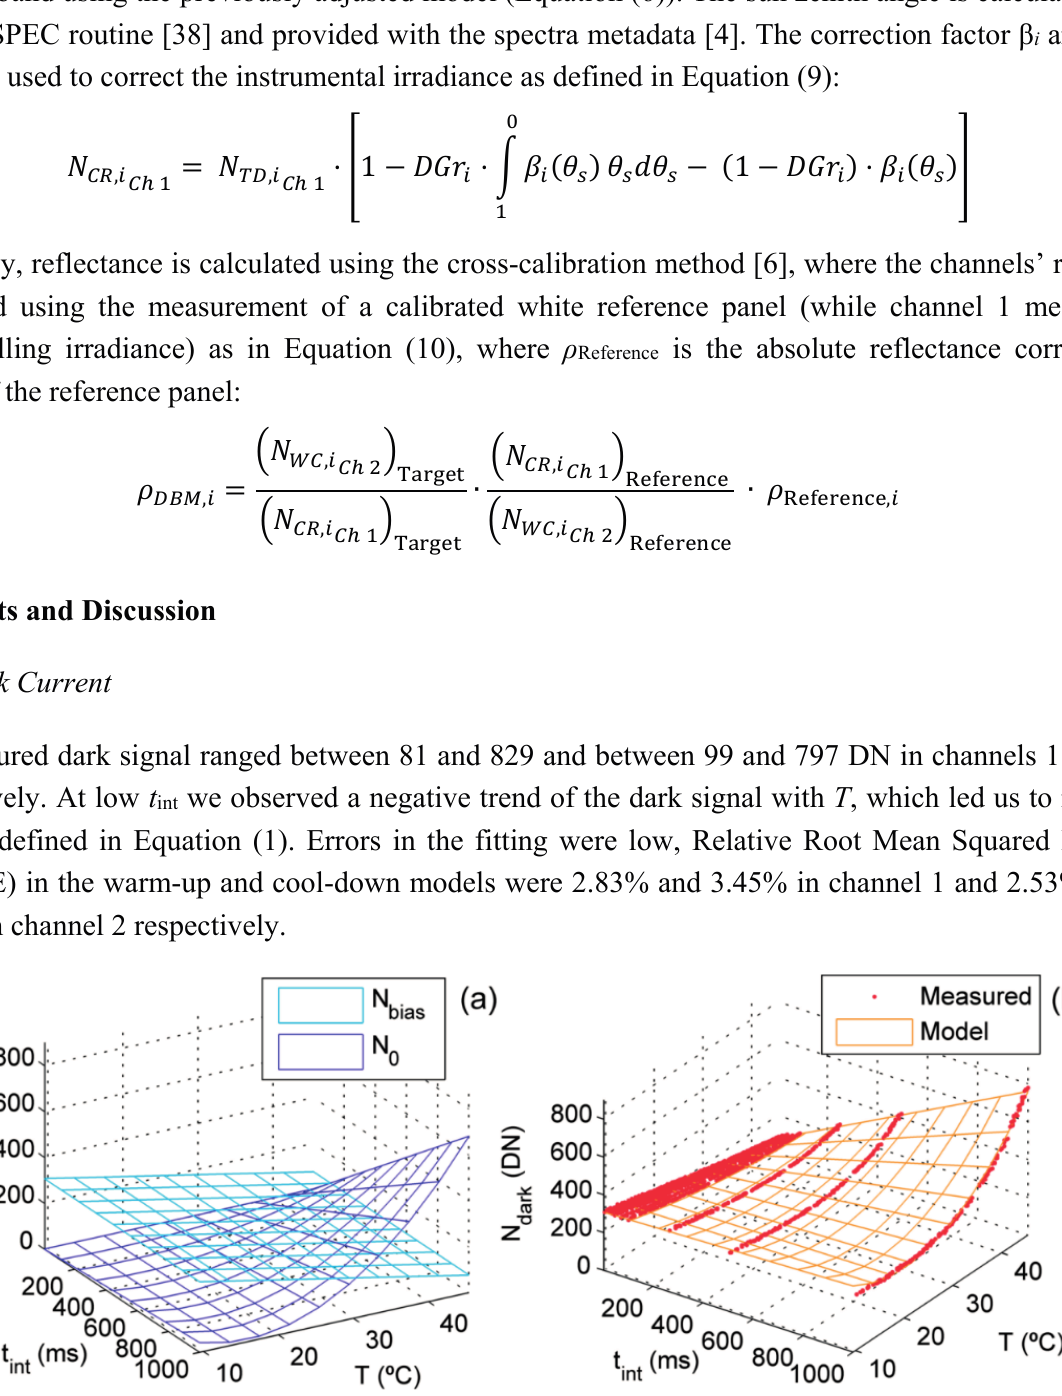
Figure 1. Channel 1’s dark signal models in pixel 170 of sensor while warming up: ( a ) Modelled dark current ( N 0 ) and electronic bias ( N bias ); ( b ) Modelled and measured dark signal ( N dark